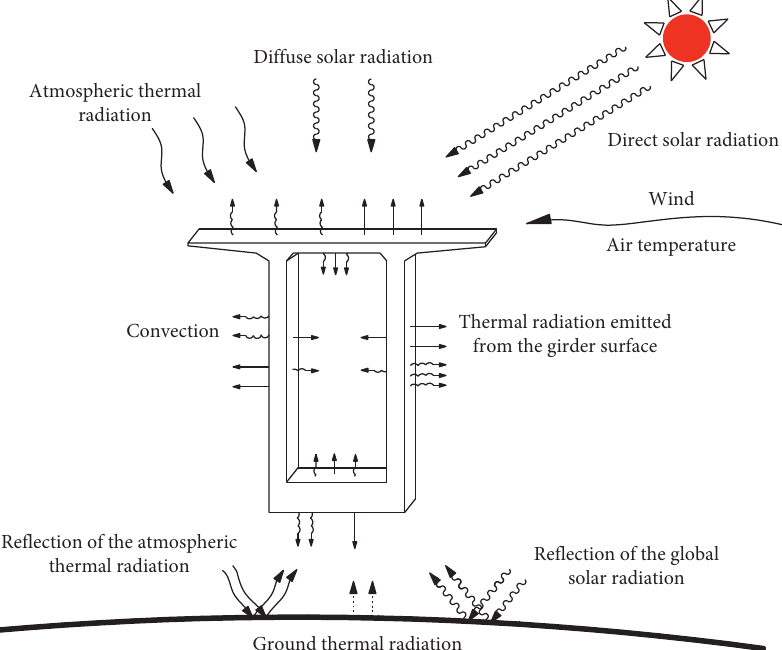
Figure 7: The heat transferred between the girder surface and environment.